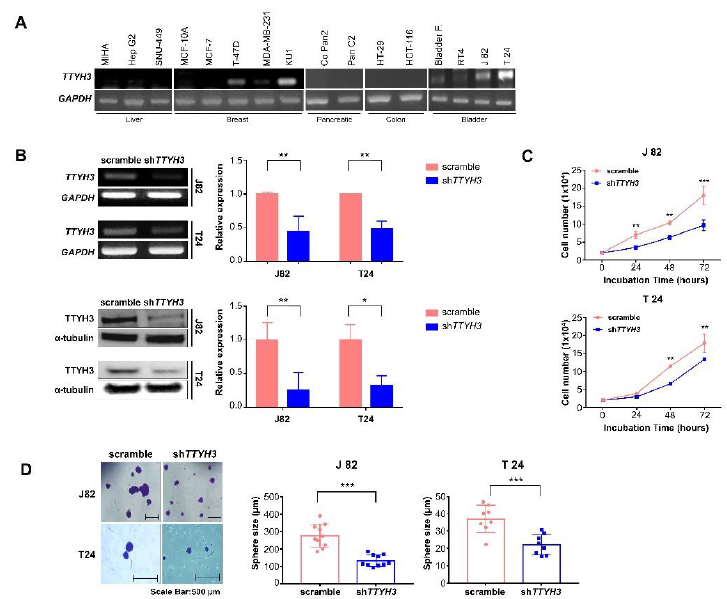
Figure 2. Knockdown of TTYH3 inhibits proliferation and sphere formation of bladder cancer cells. ( A ) Expression of TTYH3 in various cancer cell lines and normal cell lines. Normal liver cell line (MIHA); liver cancer cell lines (Hep G2 and SNU-449); normal breast epithelial cell line (MCF 10A); breast cancer cell lines (MCF7, T-47D, MDA-MB-231, and KU1 (breast cancer stem-like cells/tumor- initiating cells)); pancreatic cancer cell lines (Capan-2 and Panc2); colon cancer cell lines (HT-29 and HCT 116); normal bladder cell line (primary bladder fibroblast cells); bladder cancer cell lines (RT4, J82, and T24). Glyceraldehyde 3-phosphate dehydrogenase (GAPDH) was used as the loading control. ( B ) TTYH3 expression in scramble and short hairpin (sh) TTYH3 -transduced cells was analyzed by RT-PCR and western blot analysis in J82 and T24 bladder cancer cell lines. GAPDH or α -tubulin expression was used as the control. The band density was measured using ImageJ software and the values were presented in graph. ( C ) Effect of TTYH3 knockdown on cell proliferation was analyzed by counting of each group of cells for 3 days. ( D ) Sphere-forming ability of scramble and sh TTYH3 transduced cells. The size of the sphere was measured using ImageJ software and presented in graph. The scale bar denotes 500 µm. All statistical analyses were performed with two-way ANOVA; * p ≤ 0.05, ** p ≤ 0.01, and *** p ≤ 0.001.